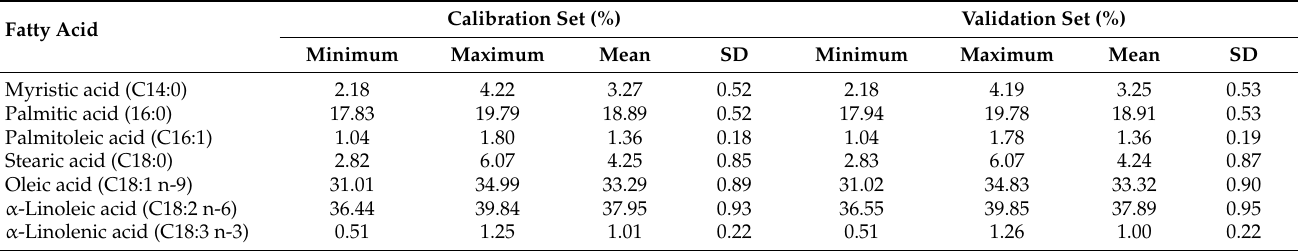
Table 4. Fatty acid content of living Tenebrio molitor larvae (relative % of total fatty acids on a dry matter basis) for calibration ( n = 80) and validation sets ( n = 40) analyzed by GC-FID.